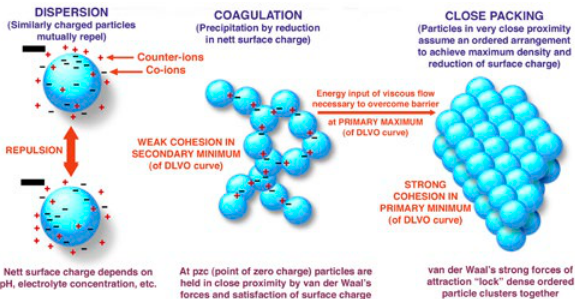
Figure 8. This diagram shows the way natural polymeric silica glo- bules closely pack together in the shear regime to reduce surface energy and form denser, physically stronger clusters that aggregate to accretions.